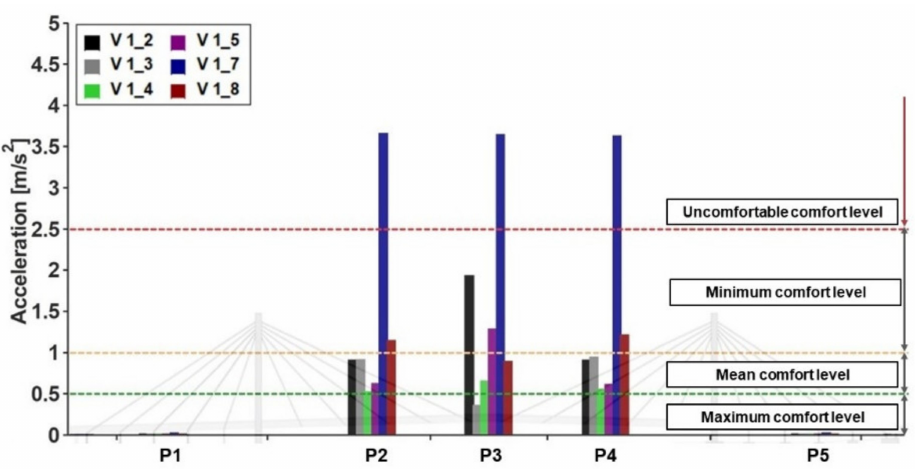
Figure 17. The comfort criteria assessment along the span of the bridge (as per S É TRA [36]).